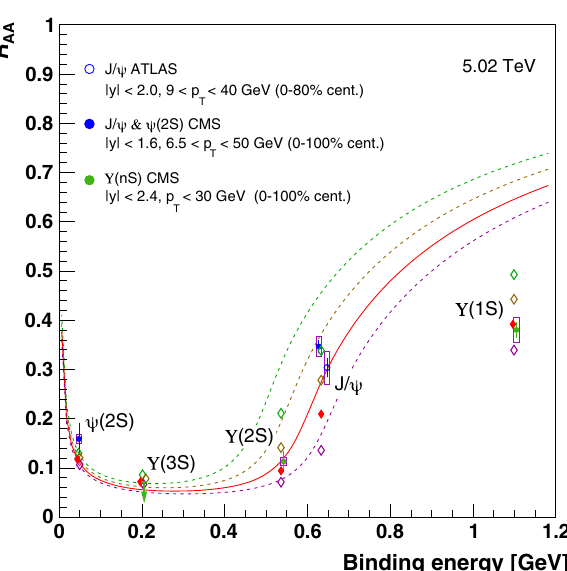
Fig. 4 Comparison between the measured values [12–14], integrated overtheprobedcentralityrange,andtheresultscomputedfor (cid:4) (cid:8) (cid:5) = 450, 500, 550 and 600MeV, respectively shown in green, brown, red and violet